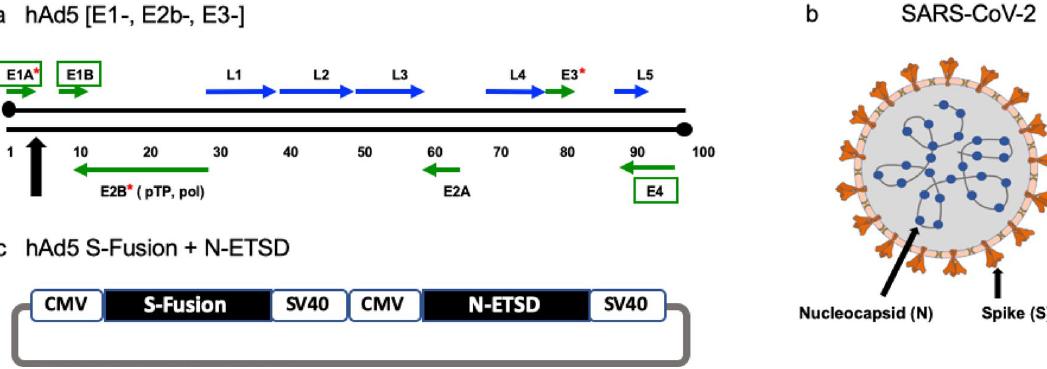
Figure 8. The SARS‑CoV‑2 virus, the hAd5 [E1‑, E2b‑, E3‑] vector and the dual antigen hAd5 S‑Fusion + N‑ETSD vaccine. ( a ) The second-generation human adenovirus serotype 5 (hAd5) vector used has the E1, E2b, and E3 regions deleted. Sequences for the vaccine antigen cargo are inserted at the black arrow. ( b ) The spike (S) glycoprotein is displayed as a trimer on the surface of SARS-CoV-2 and the nucleocapsid (N) protein is found in the virus interior, associated with the viral RNA. ( c ) The vaccine antigens are under control of the cytomegalovirus (CMV) promoter and sequences end with SV40 (HEK) 293T cells with various S-expressing hAd5 vaccines were determined by flow cytometry. HEK 293T cells (2.5 × 10 5 cells/well in 24 well plates) were grown in DMEM containing 10% FBS and PSA (100 units/mL peni- cillin, 100 μg/mL streptomycin, 0.25 μg/mL Amphotericin B) at 37 °C. Cells were either untransduced or trans- duced with hAd5 S-WT, S-WT + N-ETSD, S-Fusion, or S-Fusion + N-ETSD viral particles at a multiplicity of infection (MOI) of 10. For detection of S RBD 24 hurs after transduction, cells were transferred by gentle pipet- ting into medium and labeled with an anti-RBD monoclonal antibody (clone D003 Sino Biological) and F(ab’)2- Goat anti-Human IgG-Fc secondary antibody conjugated with R-phycoerythrin (Thermofisher). Labeled cells were acquired using a Thermo-Fisher Attune NxT flow cytometer and analyzed using Flowjo Software. Transfection of HEK 293T cells with hAd5 constructs and flow cytometric analysis of recombi - nant ACE2 binding. For recombinant ACE2 binding experiments, HEK 293T cells were transfected with hAd5 construct DNA. The constructs tested were: S-WT, S-Fusion, and S-Fusion + N-ETSD. HEK 293T cells (2.5 × 10 5 cells/well in 24 well plates) were grown in DMEM (Gibco Cat# 11995-065) with 10% FBS and 1X PSA (100 units/mL penicillin, 100 μg/mL streptomycin, 0.25 ug/mL Amphotericin B) at 37 °C. Cells were trans- fected with 0.5 μg of hAd5 plasmid DNA using a JetPrime transfection reagent (Polyplus Catalog # 89129-924) according to the manufacturer’s instructions. Cells were harvested 48 h post transfection by gently pipetting cells into medium and labeled with recombinant ACE2-Fc. Recombinant ACE2-IgG1Fc protein was produced using Maxcyte transfection in CHO-S cells that were cultured for 14 days. ACE2-IgG1Fc was then purified using a MabSelect SuRe affinity column on AKTA Explorer. Purified ACE2-IgG1Fc was dialyzed into 10 mM HEPES, pH7.4, 150 mM NaCl and concentrated to 2.6 mg/mL. For binding studies, the ACE2-IgG1Fc was used at a concentration of 1 μg/mL for binding. Cells were incubated with ACE2-Fc for 20 min and, after a washing step, were then labeled with a PE conjugated F(ab’)2-goat anti-human IgG Fc secondary antibody at a 1:100 dilution, incubated for 20 min, washed and acquired on flow cytometer. Histograms are based on normalized mode (NM) of cell count—count of cells positive for signal in PE channel. Murine immunization and blood/tissue collection. All in vivo experiments described were carried out in strict accordance with good animal practice according to NIH recommendations. All procedures for animal use were approved by the IACUC Committee at Omeros, Inc. (Seattle, WA, USA) and under an approved protocol. CD-1 female mice (Charles River Laboratories) 6–8 weeks of age were used for immunological studies per- formed at the vivarium facilities of Omeros Inc. (Seattle, WA). Mice were administered subcutaneous (SC) injections at the indicated doses in 50 µL ARM buffer (20 mM Tris pH 8.0, 25 mM NaCl, with 2.5% glycerol) or intranasal (IN) injections at the indicated doses in 10 µL ARM buffer (5 µL per nostril) while under isoflurane anesthesia. On the final day of each study, blood was collected via the submandibular vein from isoflurane- anesthetized mice for isolation of sera using a microtainer tube and then mice were euthanized for collection of spleen and lungs. Spleens were removed from each mouse and placed in 5 mL of sterile media (RPMI/HEPES/Pen/Strep/10% FBS). Splenocytes were isolated within 2 h of collection and used fresh or frozen for later analysis. Lungs were removed from each mouse, dissected in half and then immediately snap frozen on dry ice. Lung homogenates were generated by thawing one frozen lung half and homogenizing in 150 μL sterile PBS using a Fisher Scientific pestle drill. Homogenates were centrifuged at 13,000 rpm for 3 min and supernatants were utilized in ELISA and GenScript cPass surrogate neutralization assays.